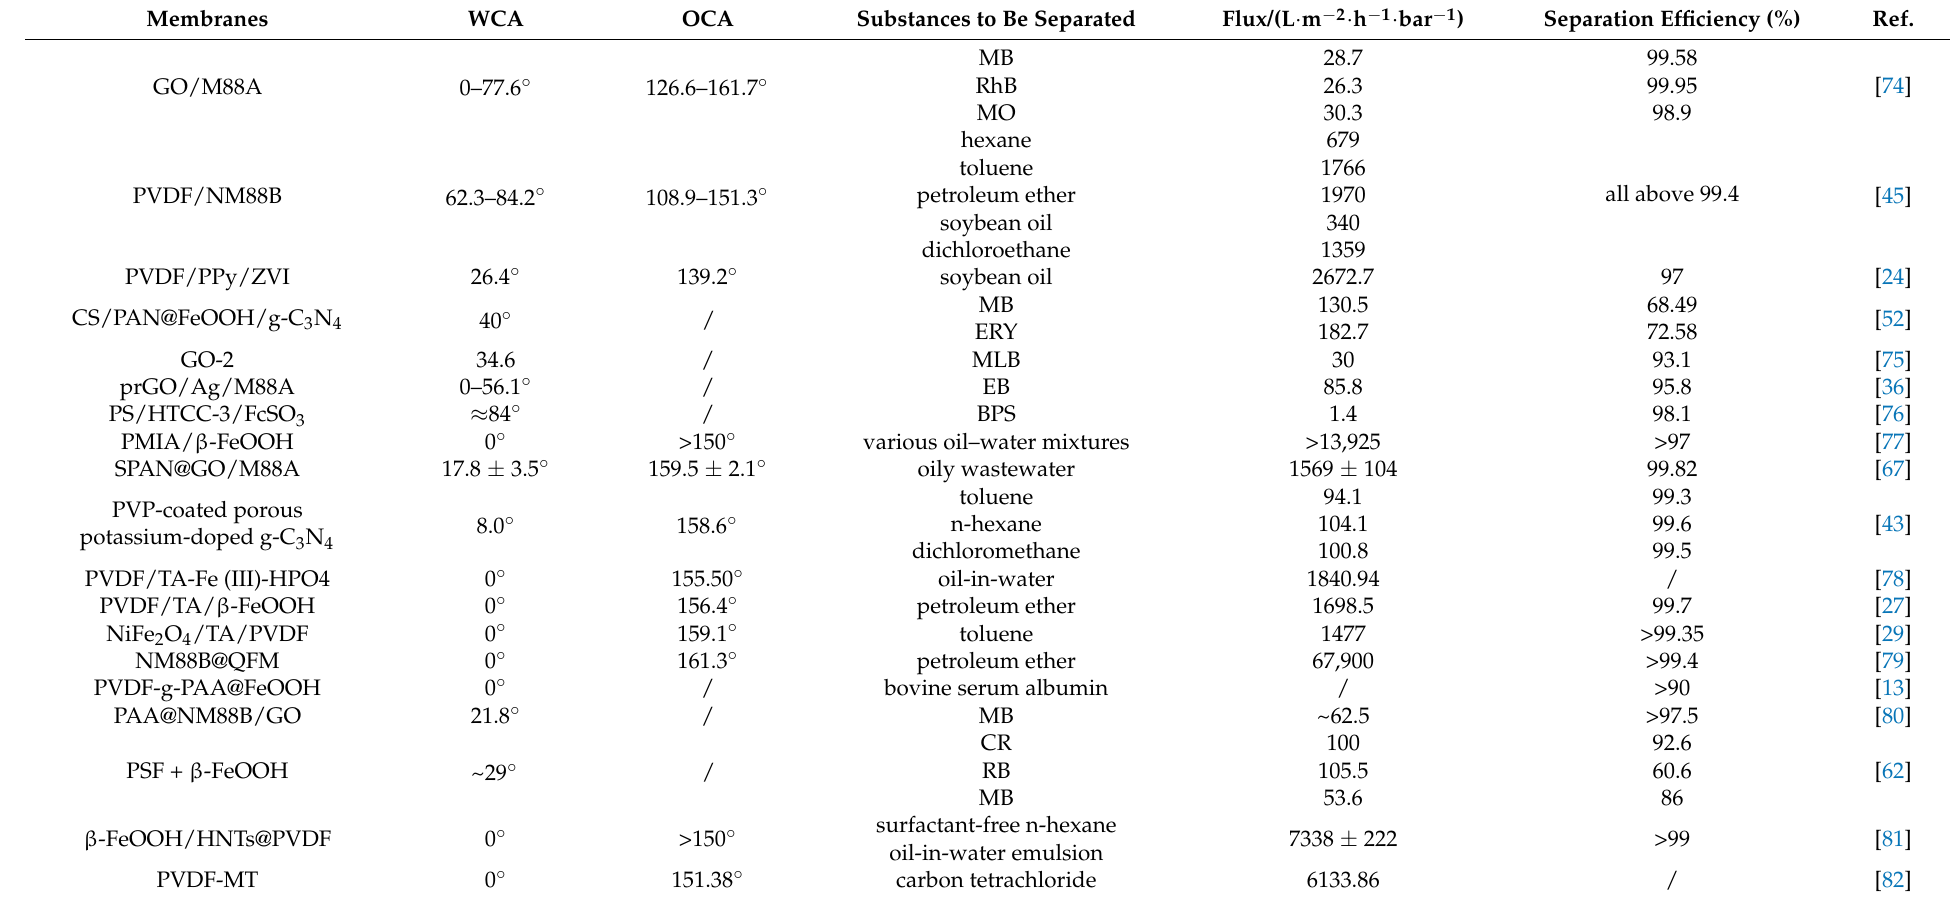
Table 1. Separation performance of different photo-Fenton